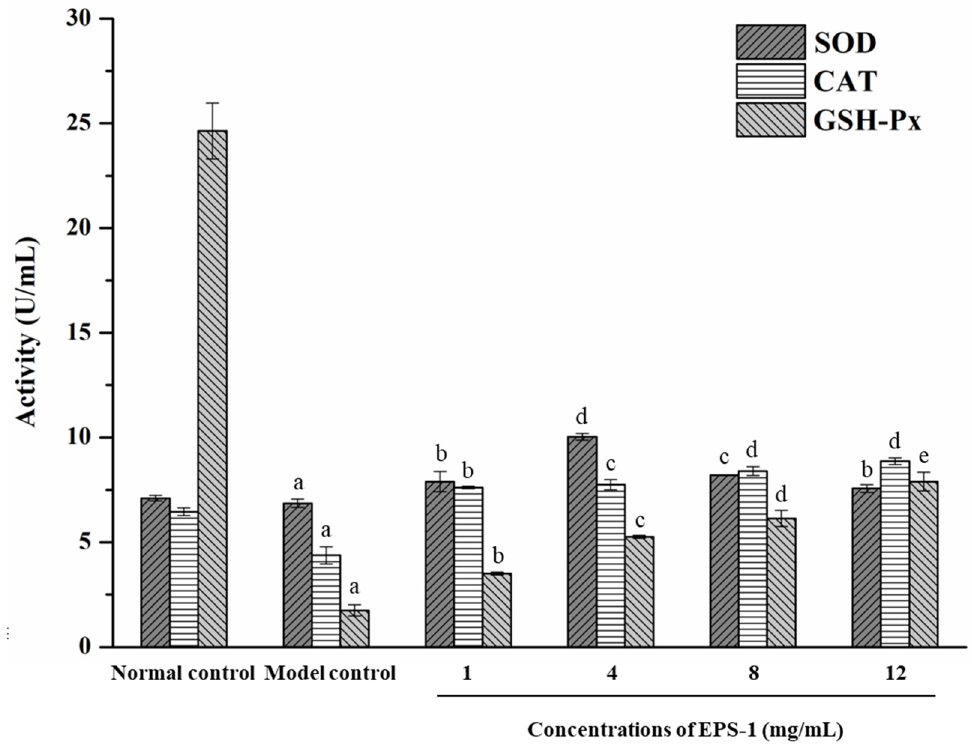
Figure 9. Effects of EPS-1 from Lc. citreum 1.2461 on the SOD, CAT and GSH-Px activities of yeast protection of oxidative damage. Data shown represent the mean ± SD of three replicates. Different lower case letters (a–d) in superscript denote significant difference ( p < 0.05).